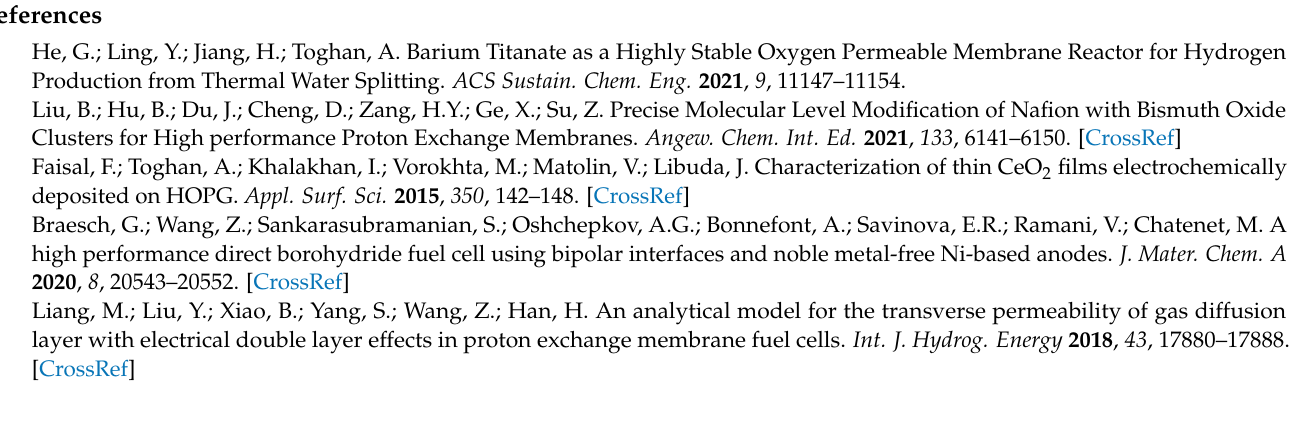
Figure S2: Nyquist plot of S-PVA/IC and S-PVA/IC/SO4ZrO2 nanocomposite membranes. Table S1: Physicochemical properties of the fabricated membranes and Nafion 117. Table S2: Ionic conductivity, Borohydride permeability, IEC and selectivity of the fabricated membranes and Nafion